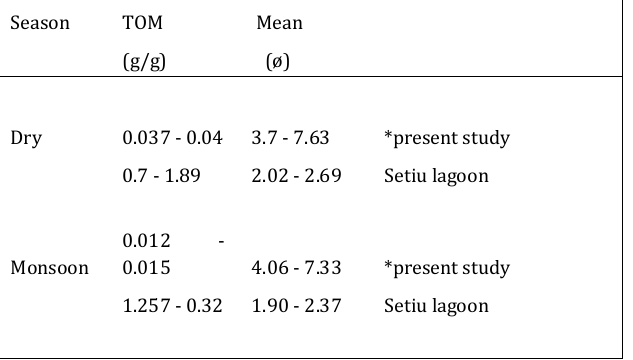
Table 7: Comparison of TOM and mean phi value between the present study and study at Setiu